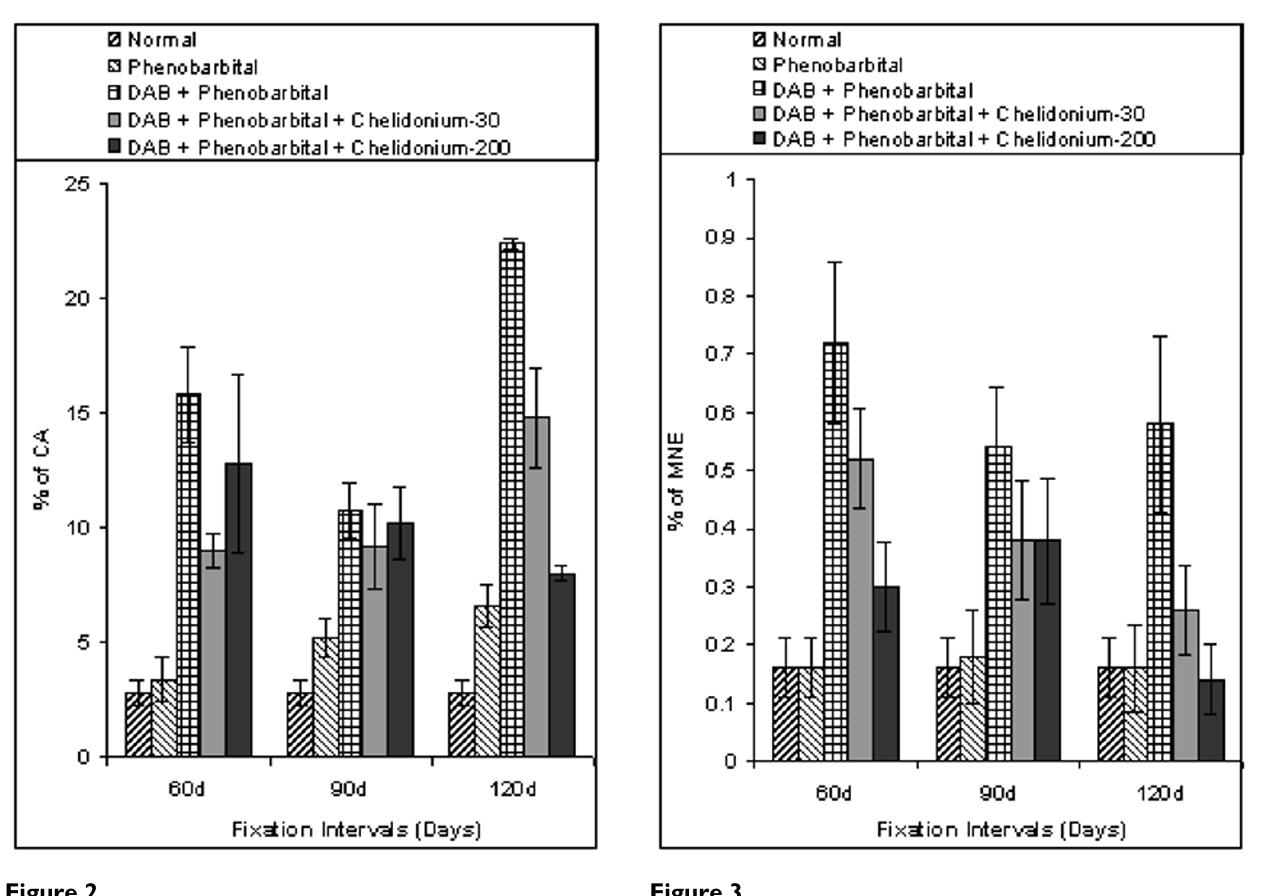
Figure 3 Showing % of MNE in different series of mice at different fix- ation